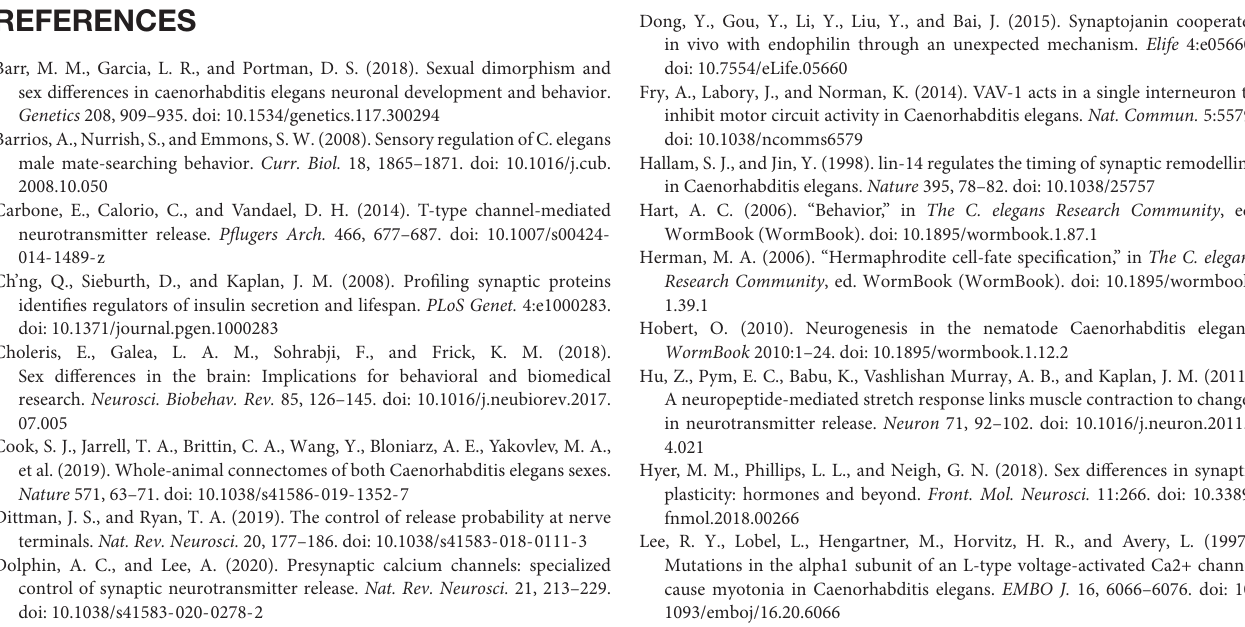
Supplementary Figure 1 | A working model of sex-specific neurotransmission at the NMJs in adult C. elegans . Adult males process more presynaptic cholinergic vesicle at NMJs and ACh receptors in muscle membrane compared to hermaphrodites. The Cav3 calcium channel CCA-1 plays male-specific roles in spontaneous neurotransmitter release at NMJs. Sex-specific characterizations in both presynaptic neurons and postsynaptic muscles work together to generate sex-specific locomotion in adult C. elegans